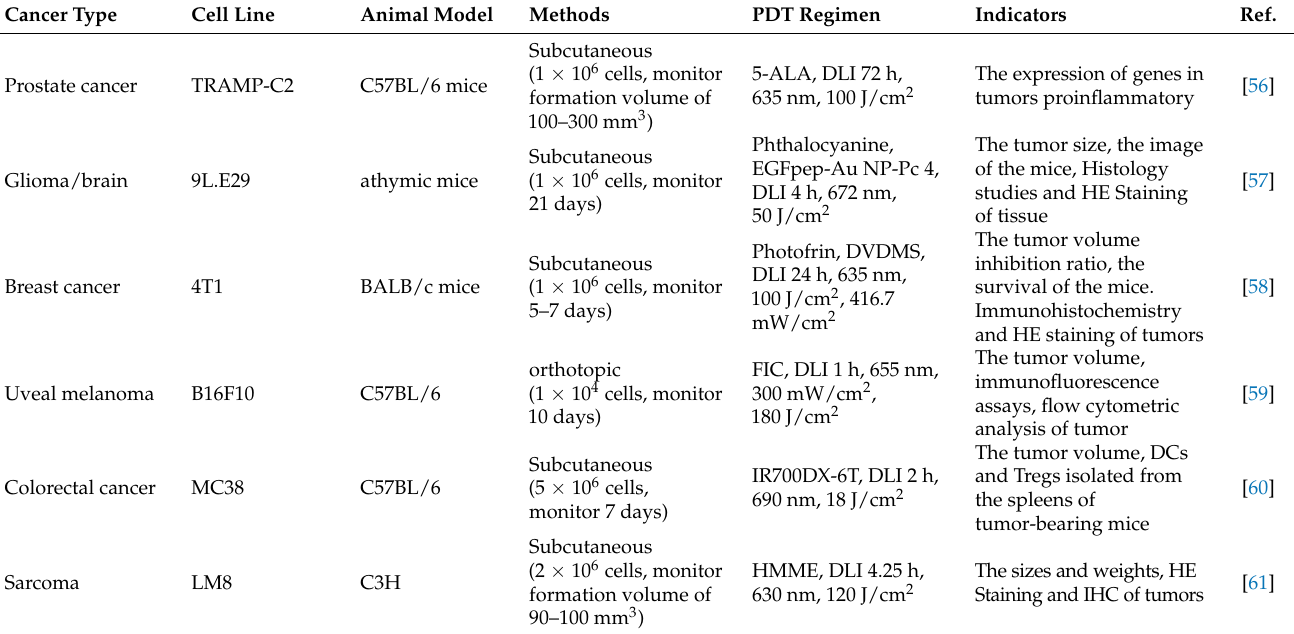
Table 3. Application of syngeneic mouse in antitumor study of